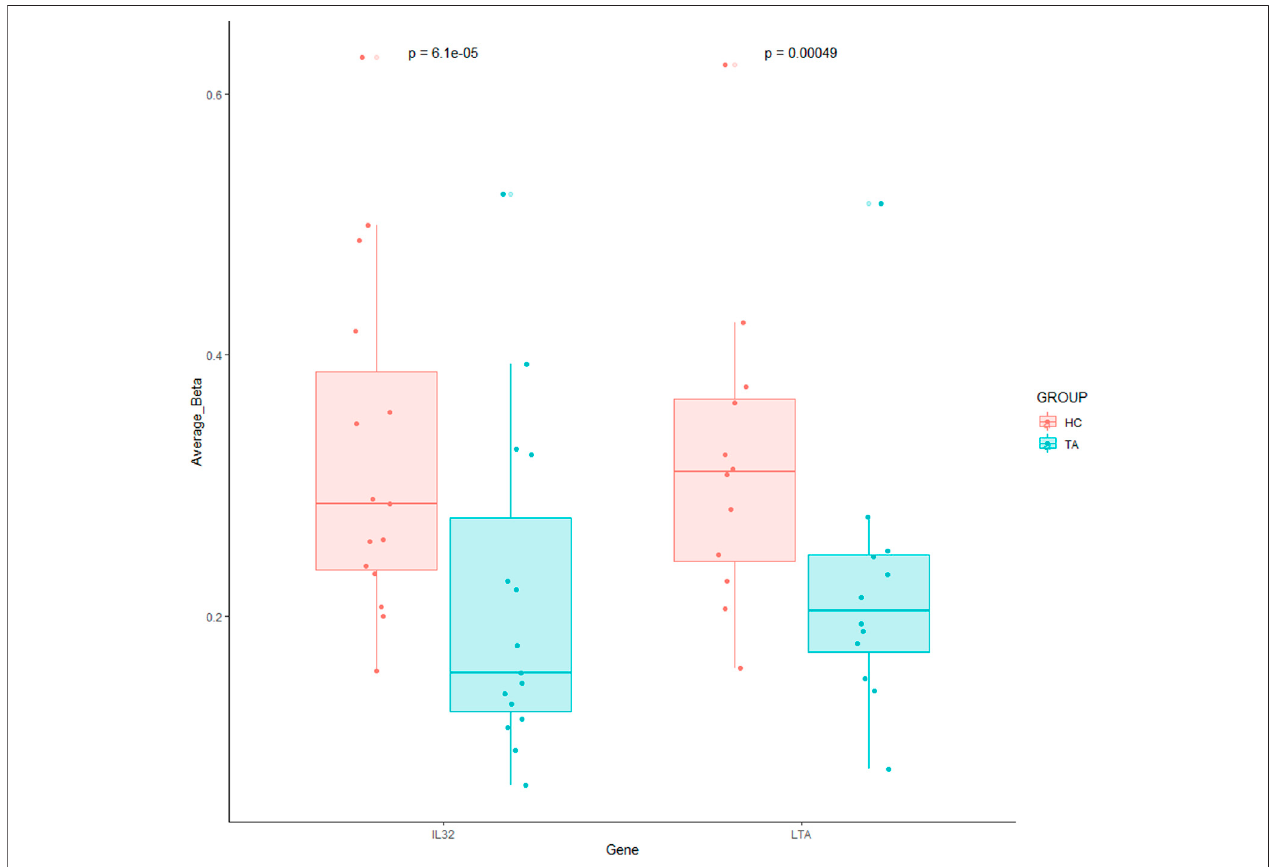
FIGURE 2 | Signi fi cantly hypomethylated genes in CD8 T-cells of patients with TA. Each dot indicates each CpG probe measured within this gene. A Wilcoxon matched paired test was used to compare between the groups against each CpG probe.